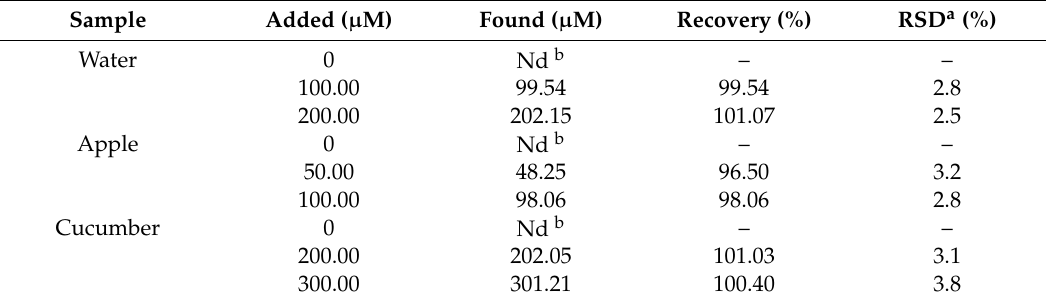
Table 2. Detection PMT in natural samples using standard addition